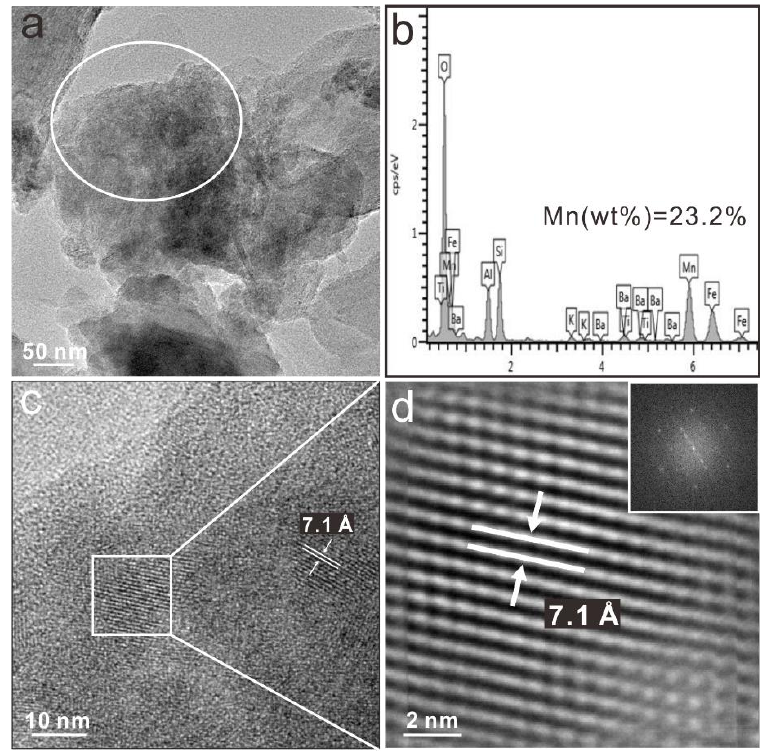
Figure 4. TEM morphology ( a ), chemical composition ( b ), lattice photograph ( c ) and di ff raction pattern ( d ) of Mn-rich grains in the soil Fe / Mn coating. Panel ( b ) shows the chemical composition of the selected oval region in panel ( a ). The lattice fringes and di ff raction pattern in panel ( d ) are the FFT (fast Fourier transform) and inverse FFT results of the selected rectangular region in panel ( c ).